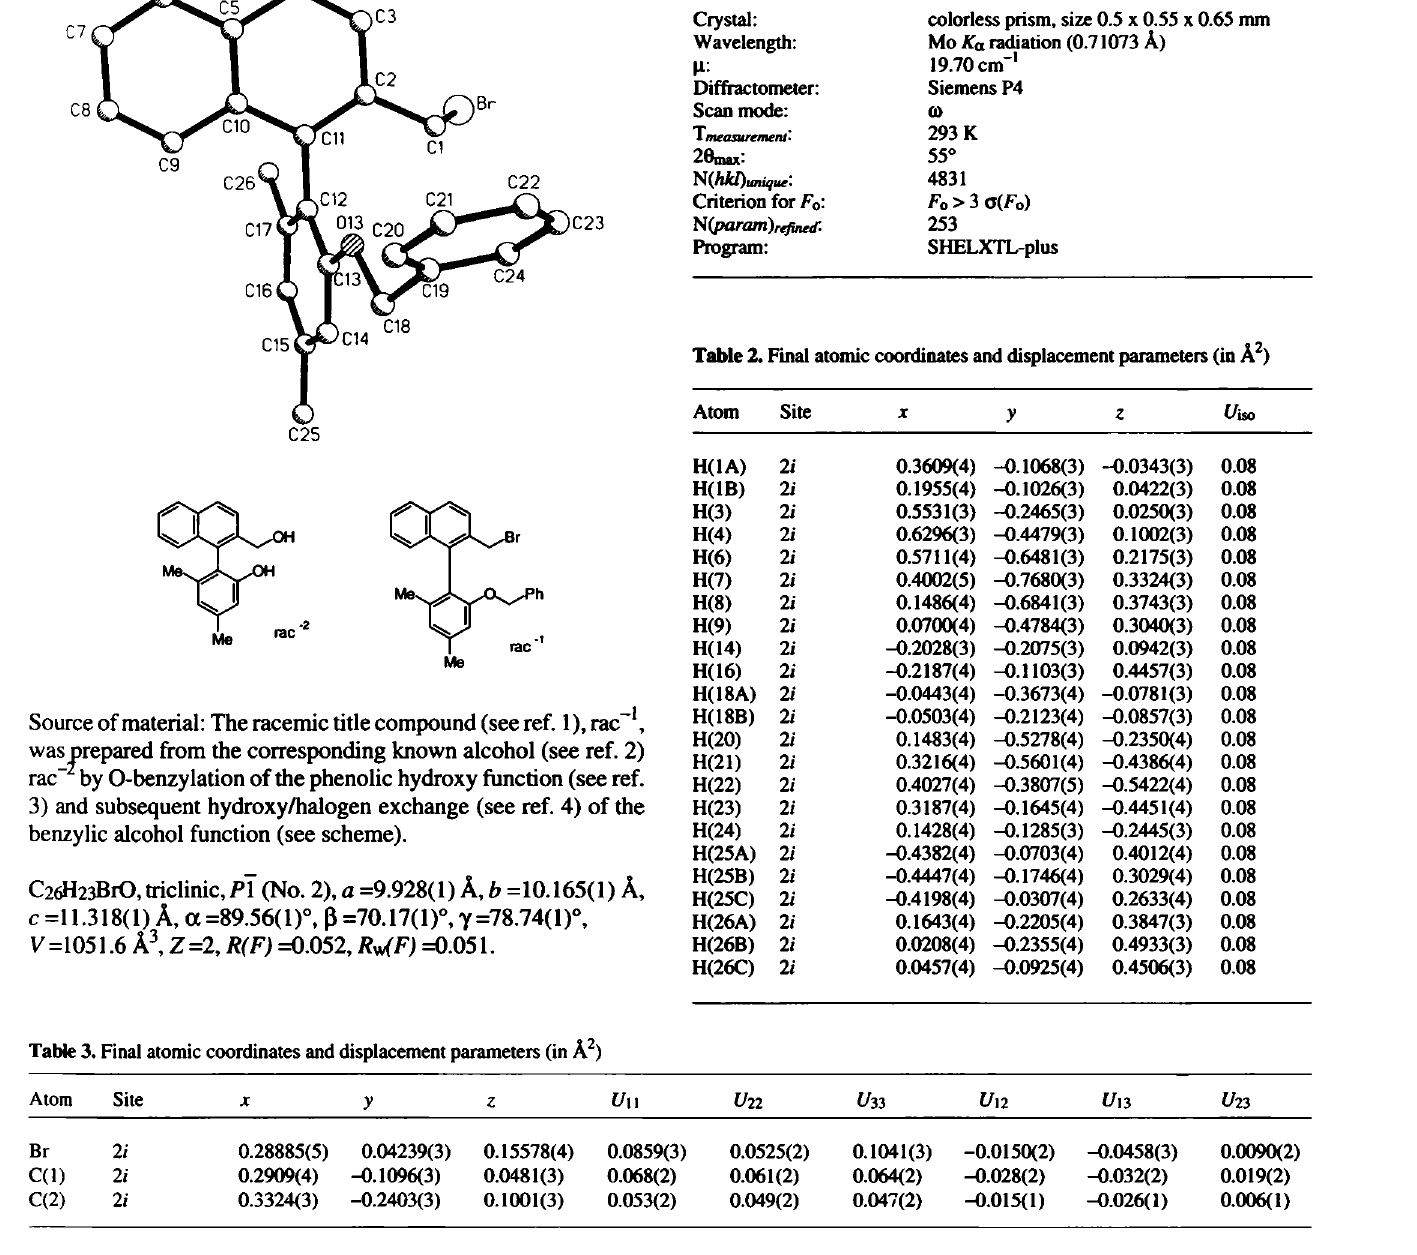
Table 1. Parameters used for the X-ray data collection